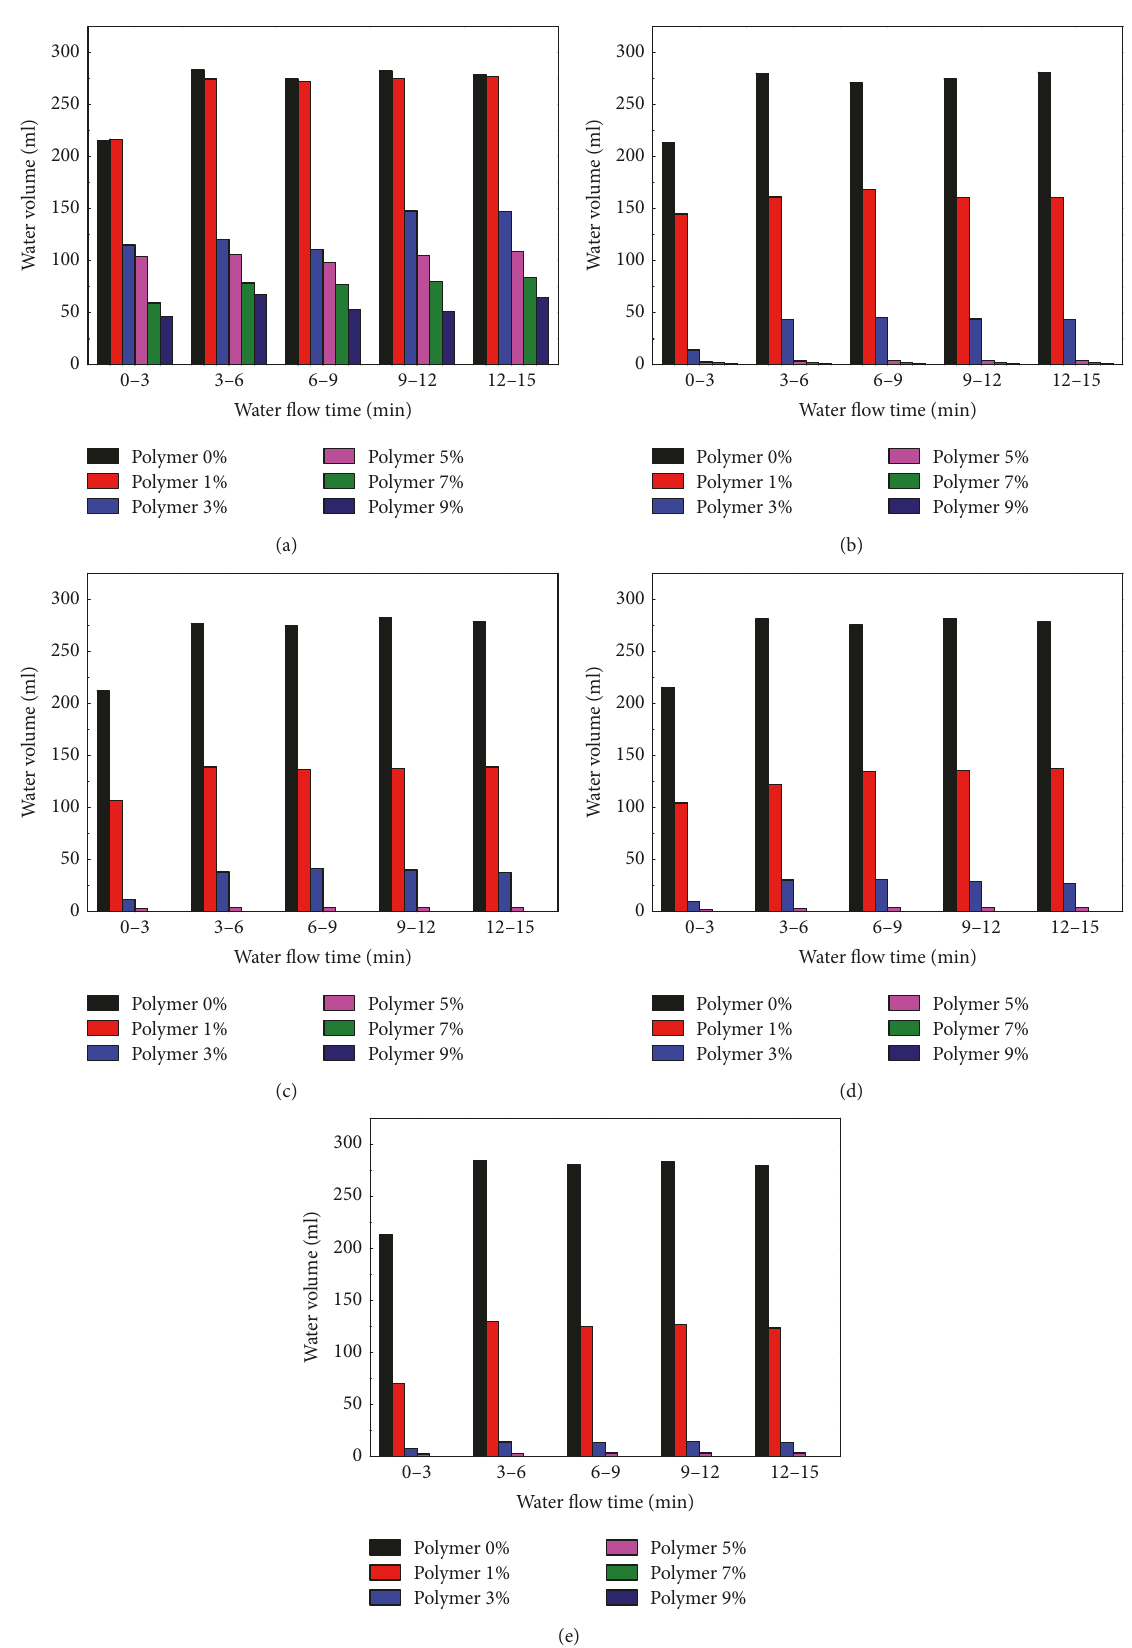
Figure 8: The volume of running water from bottom outlet: (a) curing time 0 h; (b) curing time 3h; (c) curing time 6 h; (d) curing time 12h; (e) curing time 24